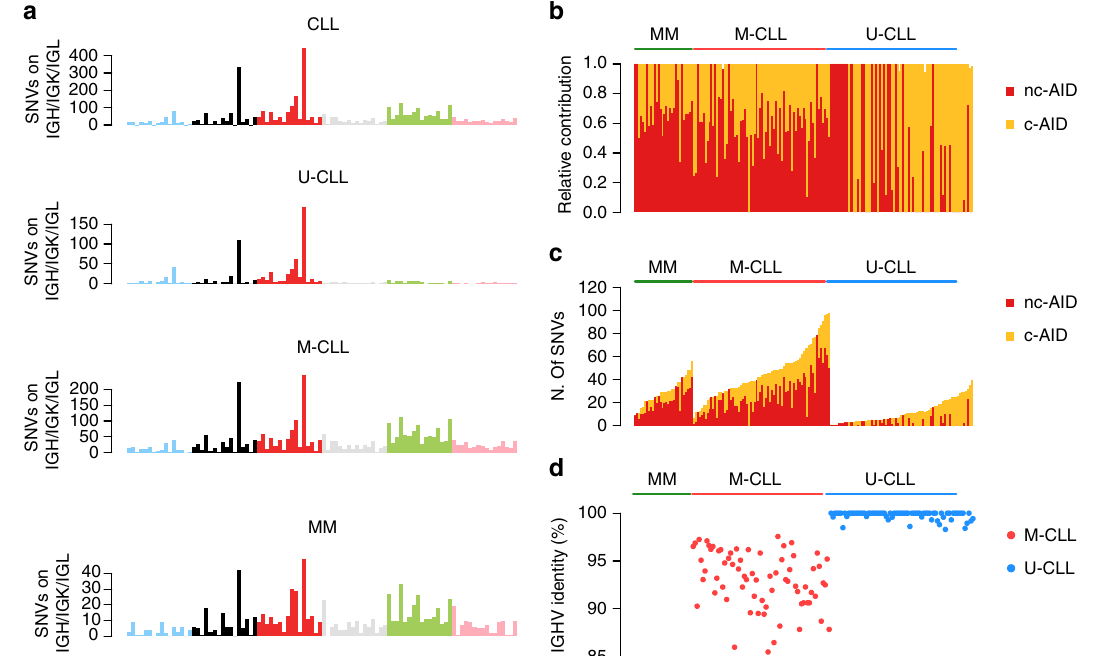
Fig. 4 Mutational signature landscape of immunoglobulin loci. a The 96-mutational classes of all SNV within IGH/IGK/IGL loci. Canonical AID (c-AID) represented the main mutational process within these regions in all tested hematological malignancies, including U-CLLs as recently described 3,10,52 . b , c Mutational signature relative ( b ) and absolute ( c ) contribution within IGH/IGK/IGL loci for each sample tested by deconstructSig. d The Sanger- sequencing-based IGHV mutational status available for each CLL case. Sig. =